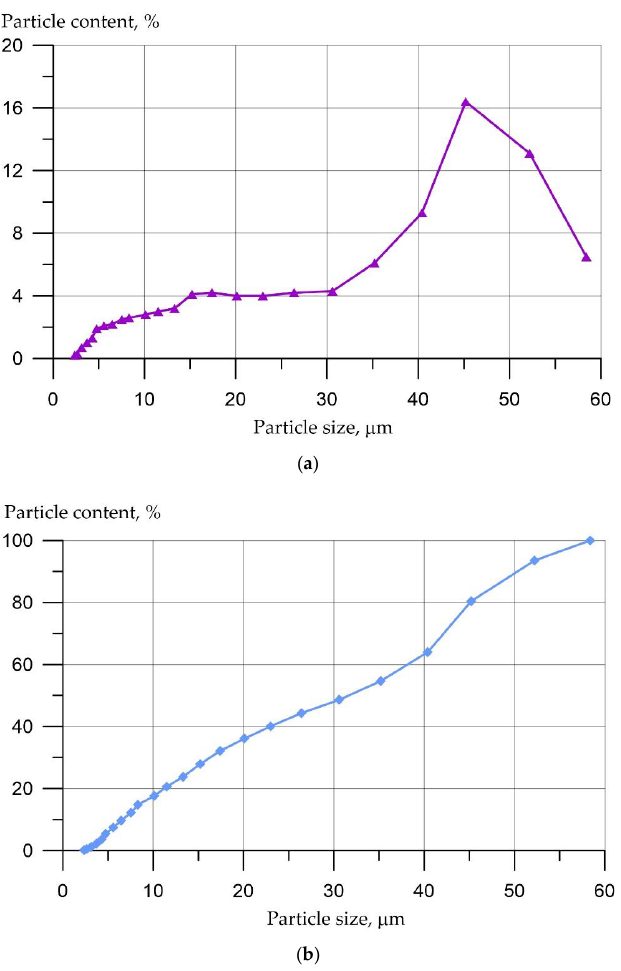
Figure 1. PSD curves of mussel shell powder (MSP): ( a ) PSD; ( b ) Cumulative curve.